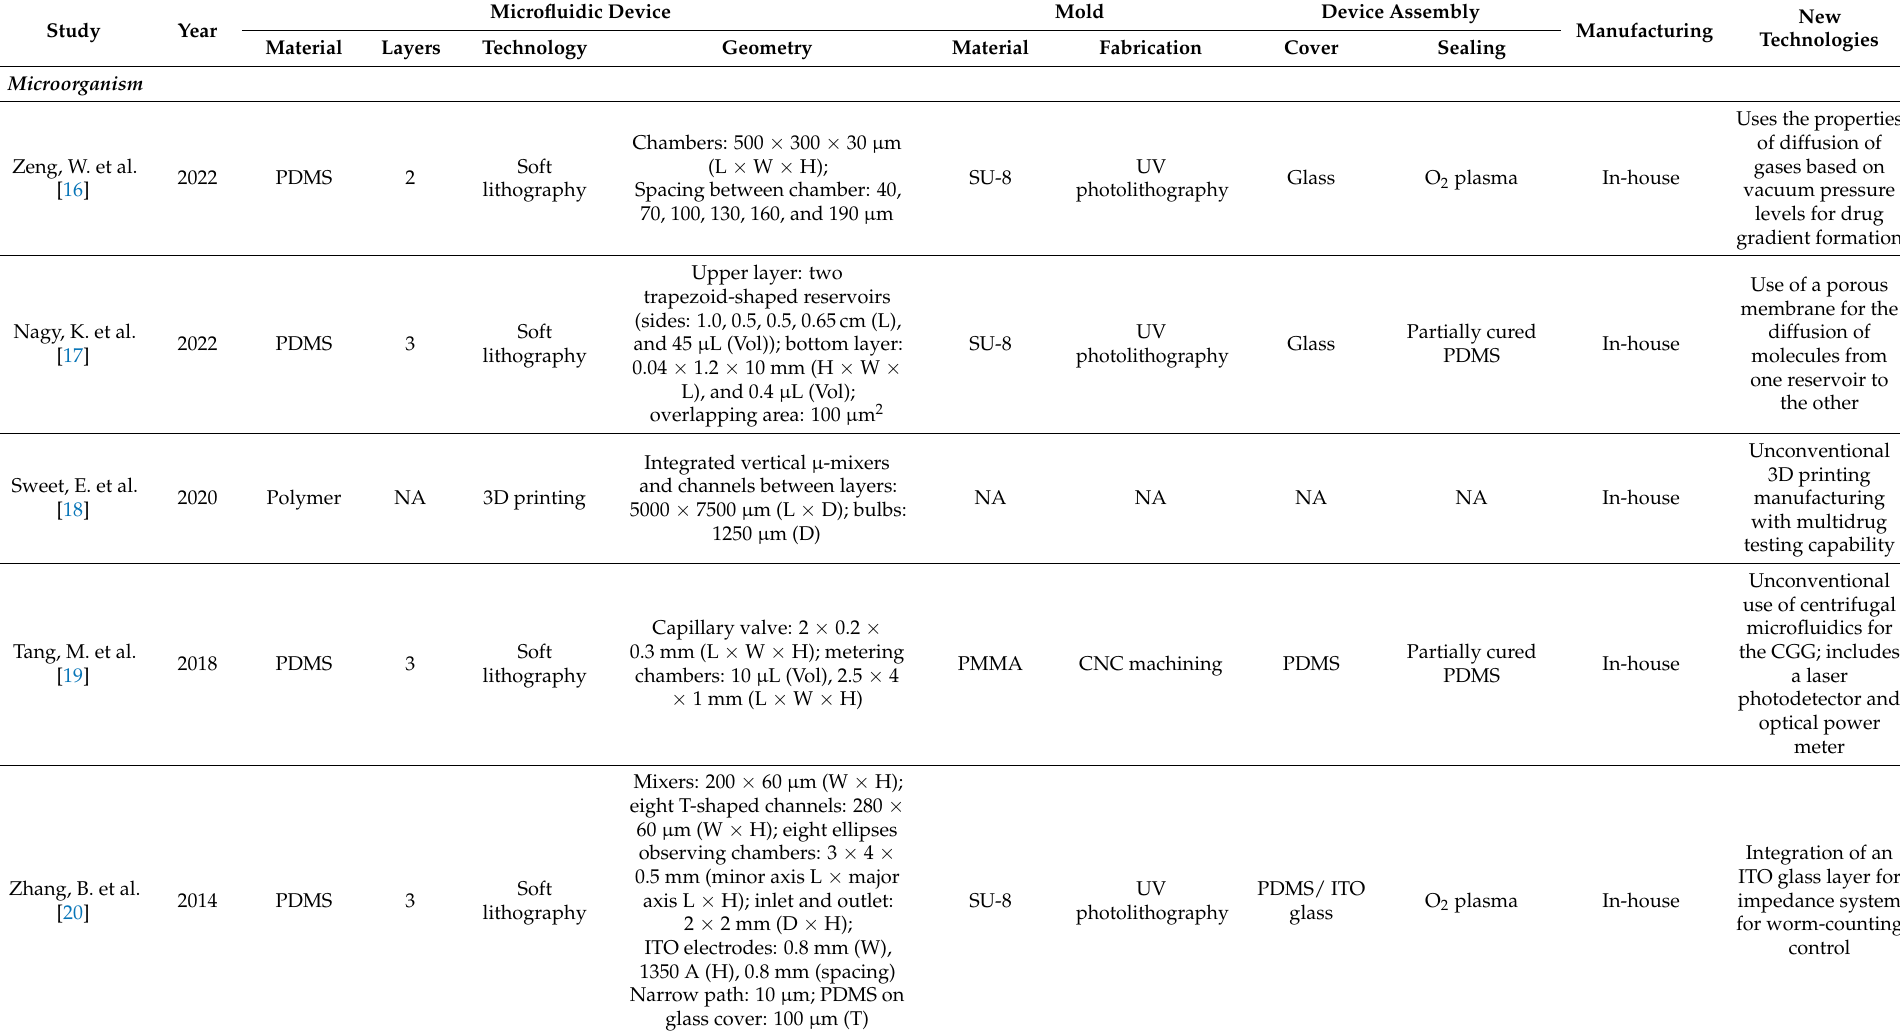
Table 1. Characteristics, design, and fabrication of concentration gradient generator microfluidic devices for toxicity